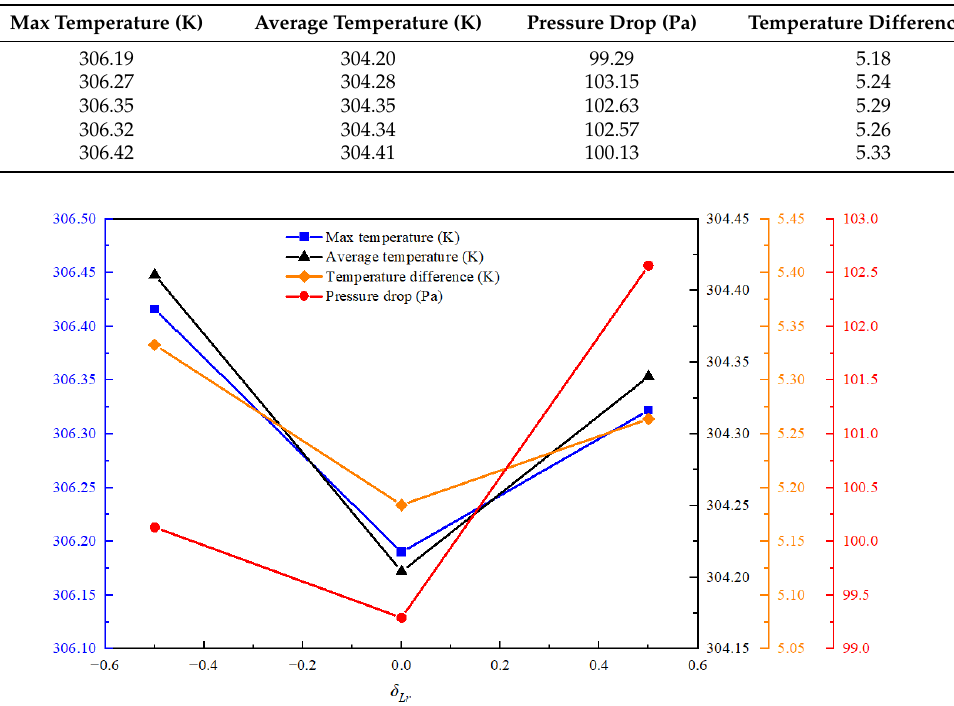
Figure 15. Effect of different pin-fin distributions along the length direction.